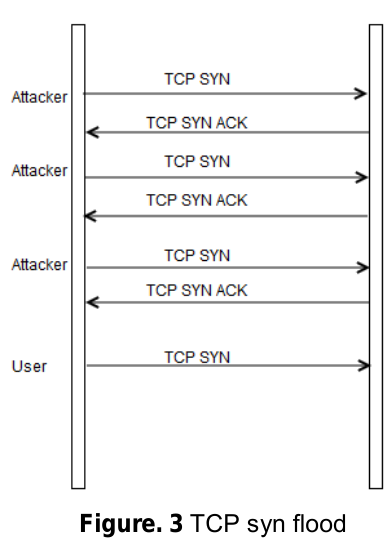
Figure. 3 TCP syn flood